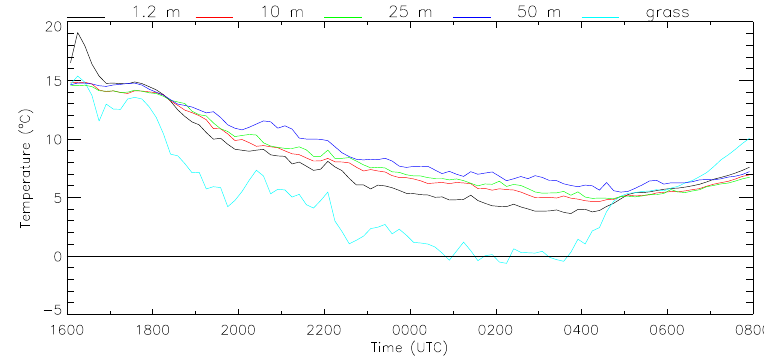
Figure 4. Temperature evolution at various levels for skyborry, 18–19 September 2019.